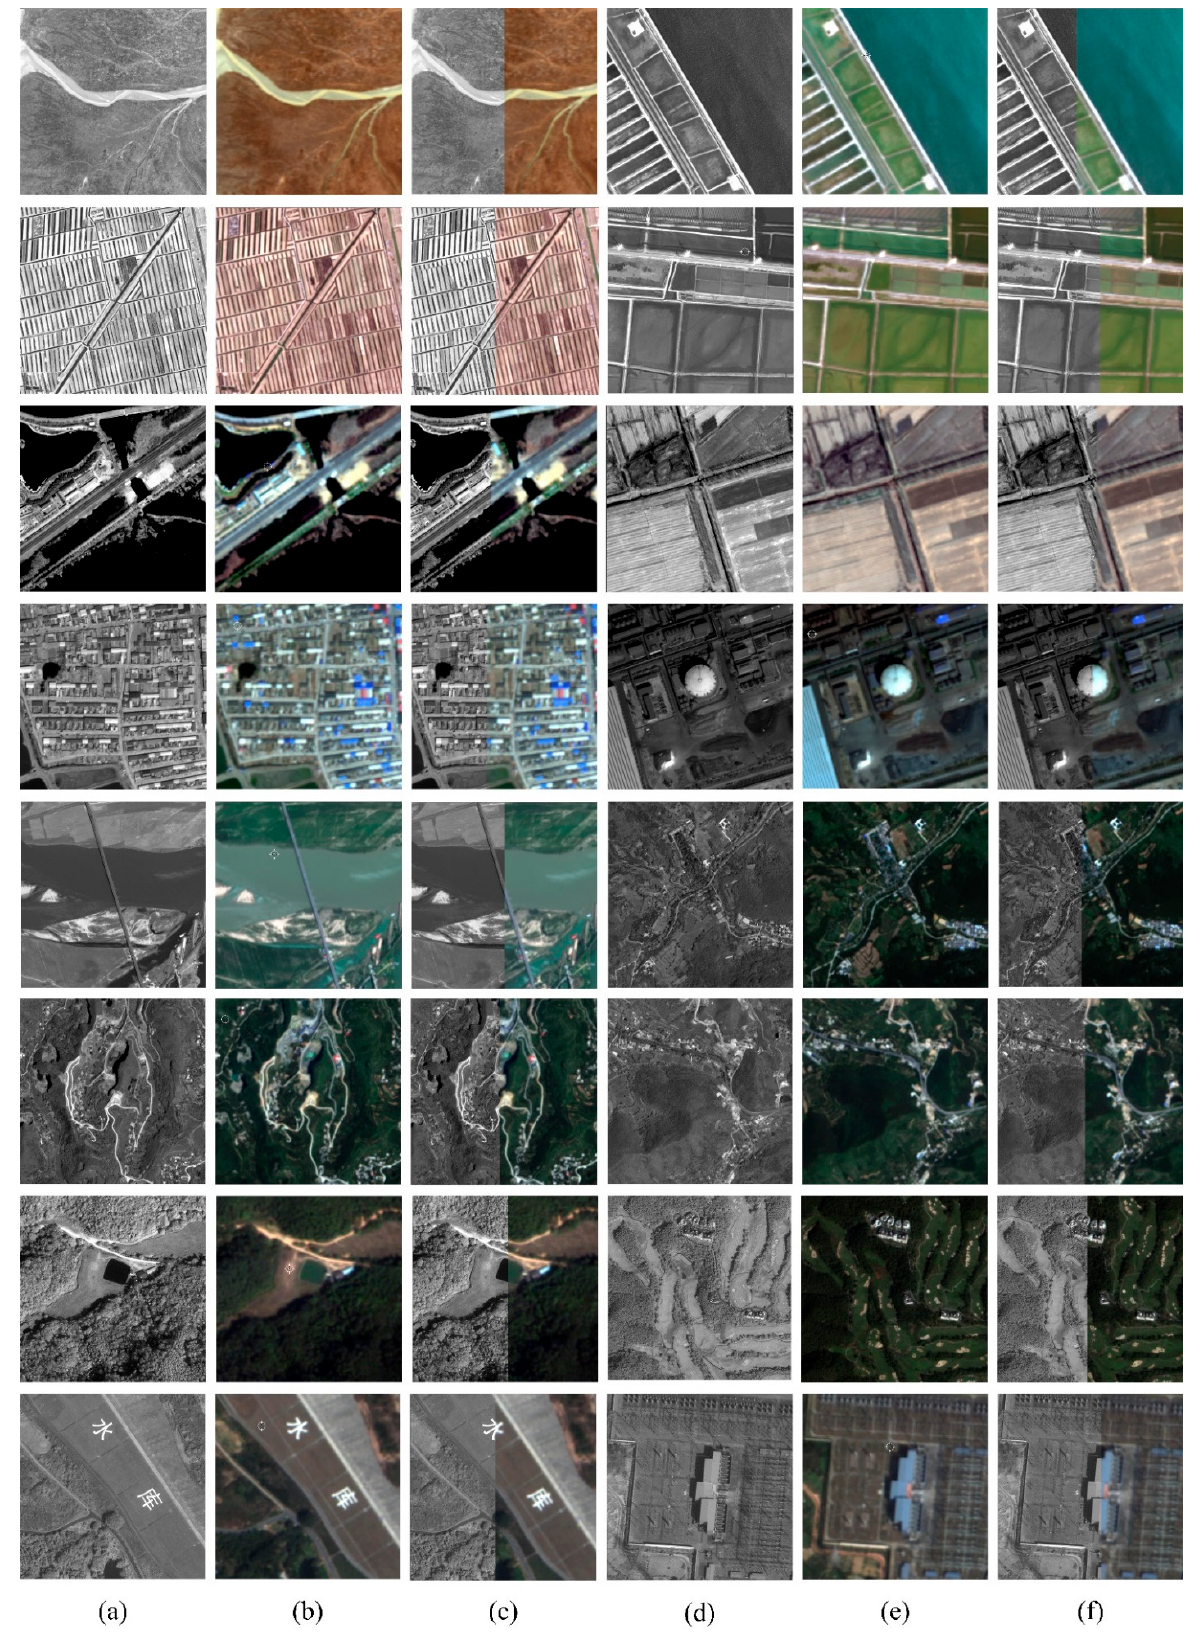
Figure 5. A detailed comparison of registered images. ( a , d ) PAN; ( b , e ) MS; ( c , f ) comparison. Lines 1 and 2 are GF-6, lines 3 and 4 are GF-7, lines 5 and 6 are ZY3-02, and lines 7 and 8 are SV-1.